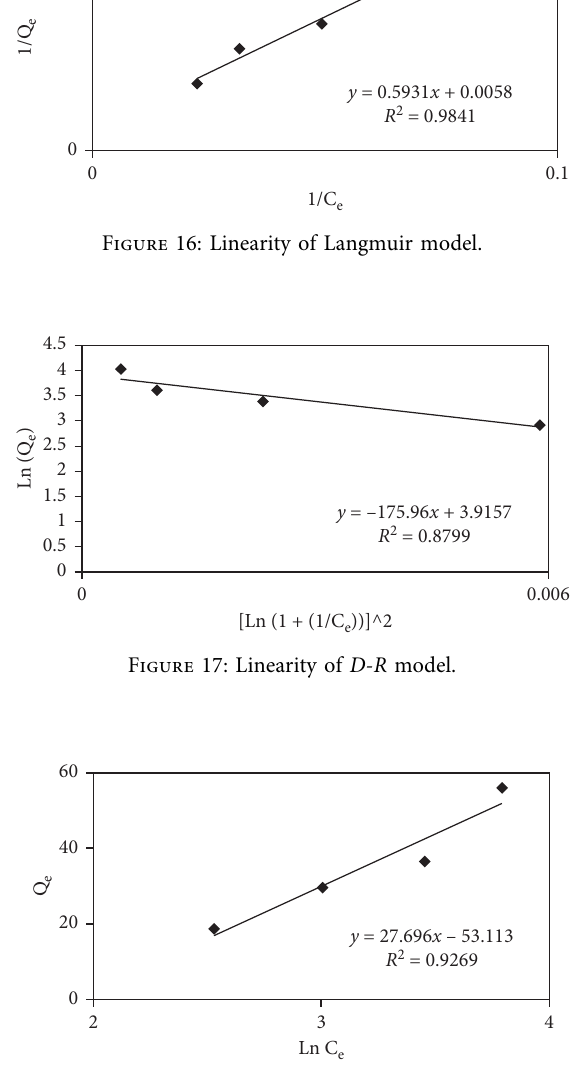
Figure 18: Linearity of Temkin